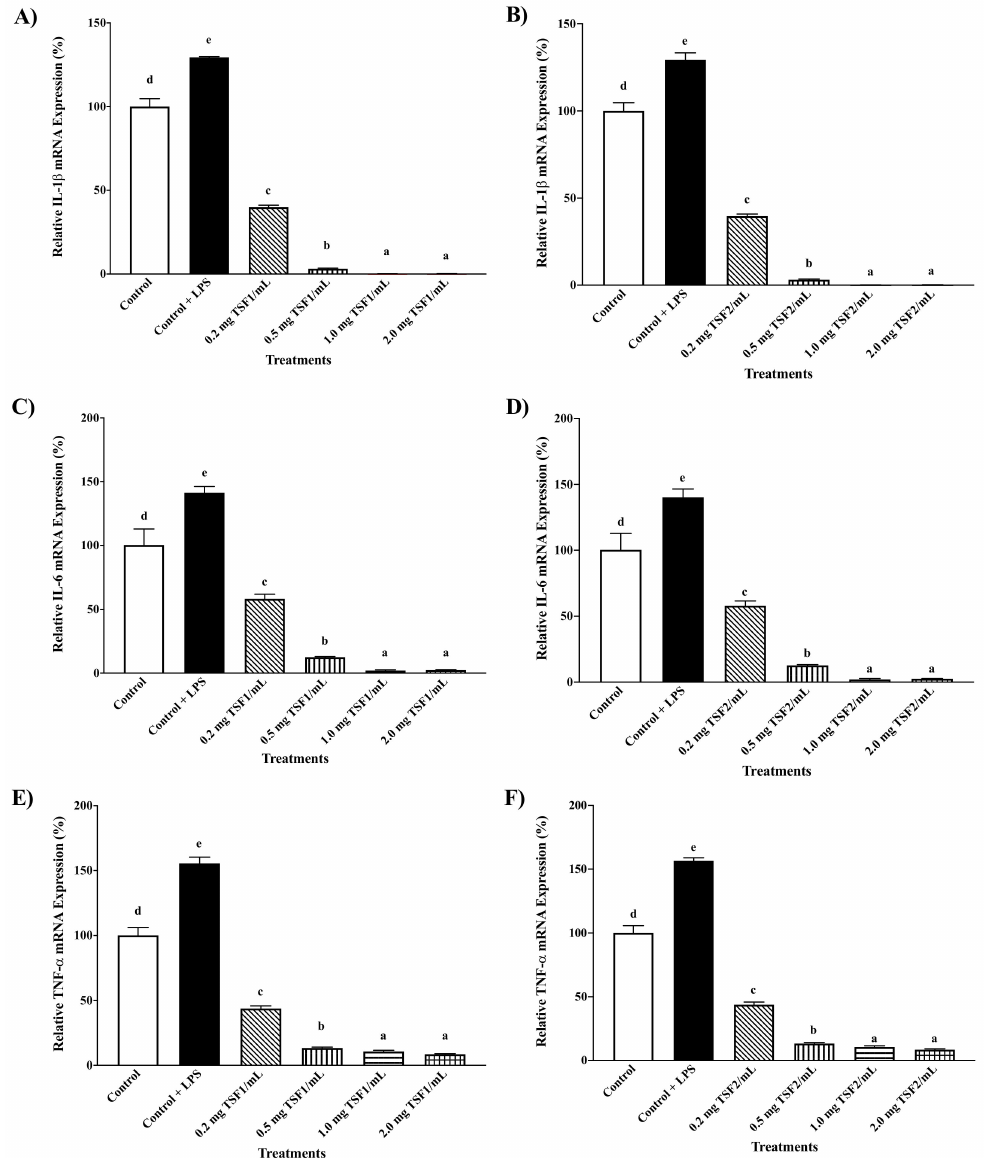
Figure 3. Anti-inflammatory capacities of tomato seed flour extracts at concentrations of 0.2, 0.5, 1.0, and 2.0 mg tomato seed flour (TSF)/mL in THP-1 macrophages, ( A , C , E ): TSF1, the first batch of tomato seed flour extract and ( B , D , F ): TSF2, the second batch of tomato seed flour extract. Control, No-treatment; LPS, lipopolysaccharides; IL-1 β , interleukin-1 beta; IL-6, interleukin-6; TNF- α , tumor necrosis factor alpha; Different letters demonstrate significant difference ( p ≤